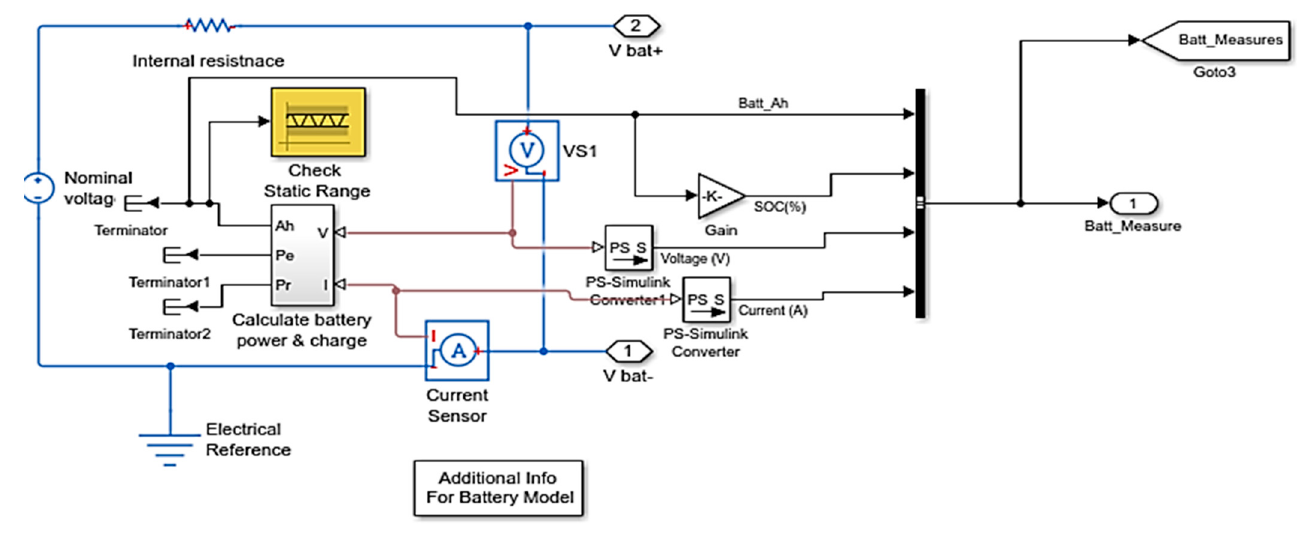
Figure 3. Battery model .